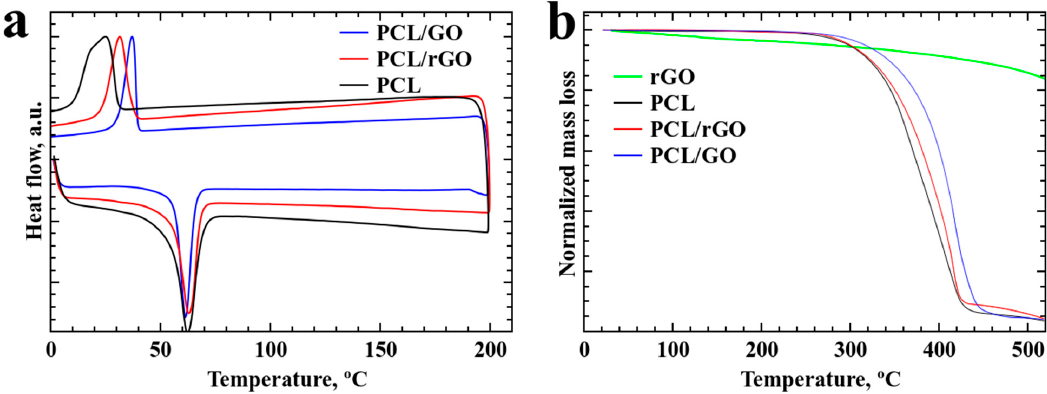
Figure 5. ( a ) DSC and ( b ) TGA spectra of the samples.